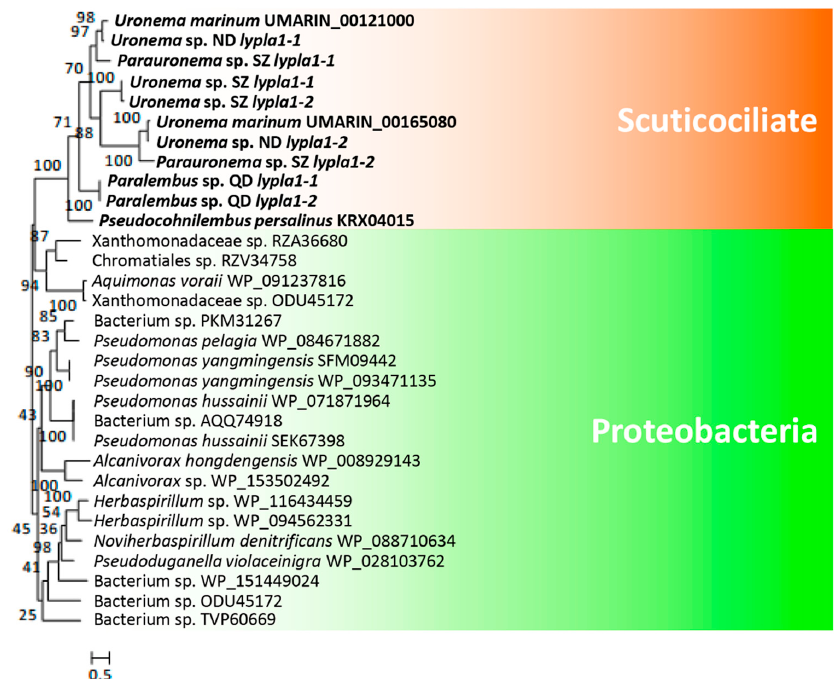
Figure 6. Phylogenetic tree of lypla1 genes in scuticociliates and bacteria. lypla1 genes were identified in all scuticociliates. The top 20 prokaryotic BLASTP hits (using the encoded U. marinum LYPLA1 proteins as the seed sequence) in the NCBI non-redundant protein database were used to construct the phylogenetic tree.